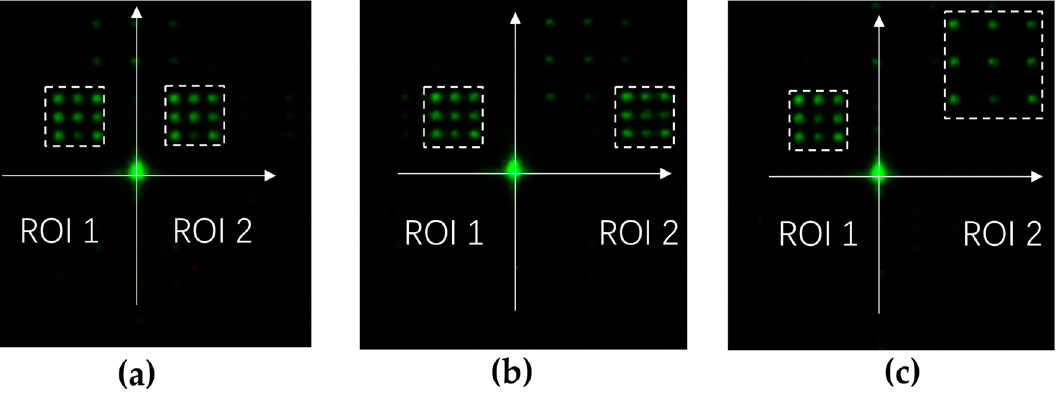
Figure 7. Two-point beam steering: ( a ) rotation, ( b ) linear x-shift, and ( c ) linear y-shift. The combination of separation ( p ), rotation ( θ ), and the shifting of two points ( q , r ) can steer the beam into two ROIs. Figure 8 shows a long-exposure image of beam steering into two ROIs. In each of the frames of the MEMS PLM, the beam is steered into a point of each of the regions. Two ROIs were simultaneously and sequentially scanned updating parameters ( p , θ , q , r ).